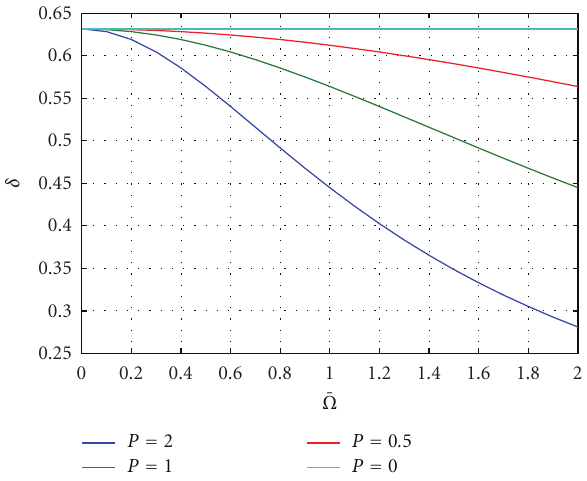
Figure 6: Log Decrement as a Function of Dimensionless Running Speed, ζ r ,0 = 0 . 1.